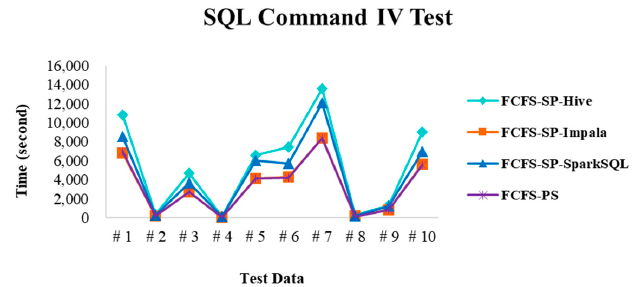
Figure 22. Execution time of SQL command III in test environment II.